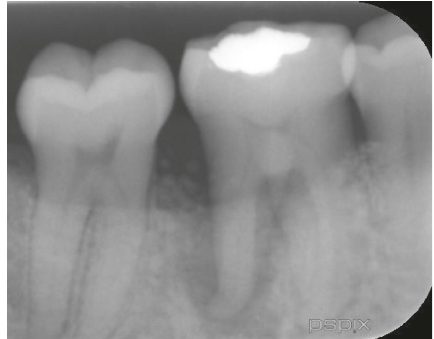
Figure 1: Preoperative periapical